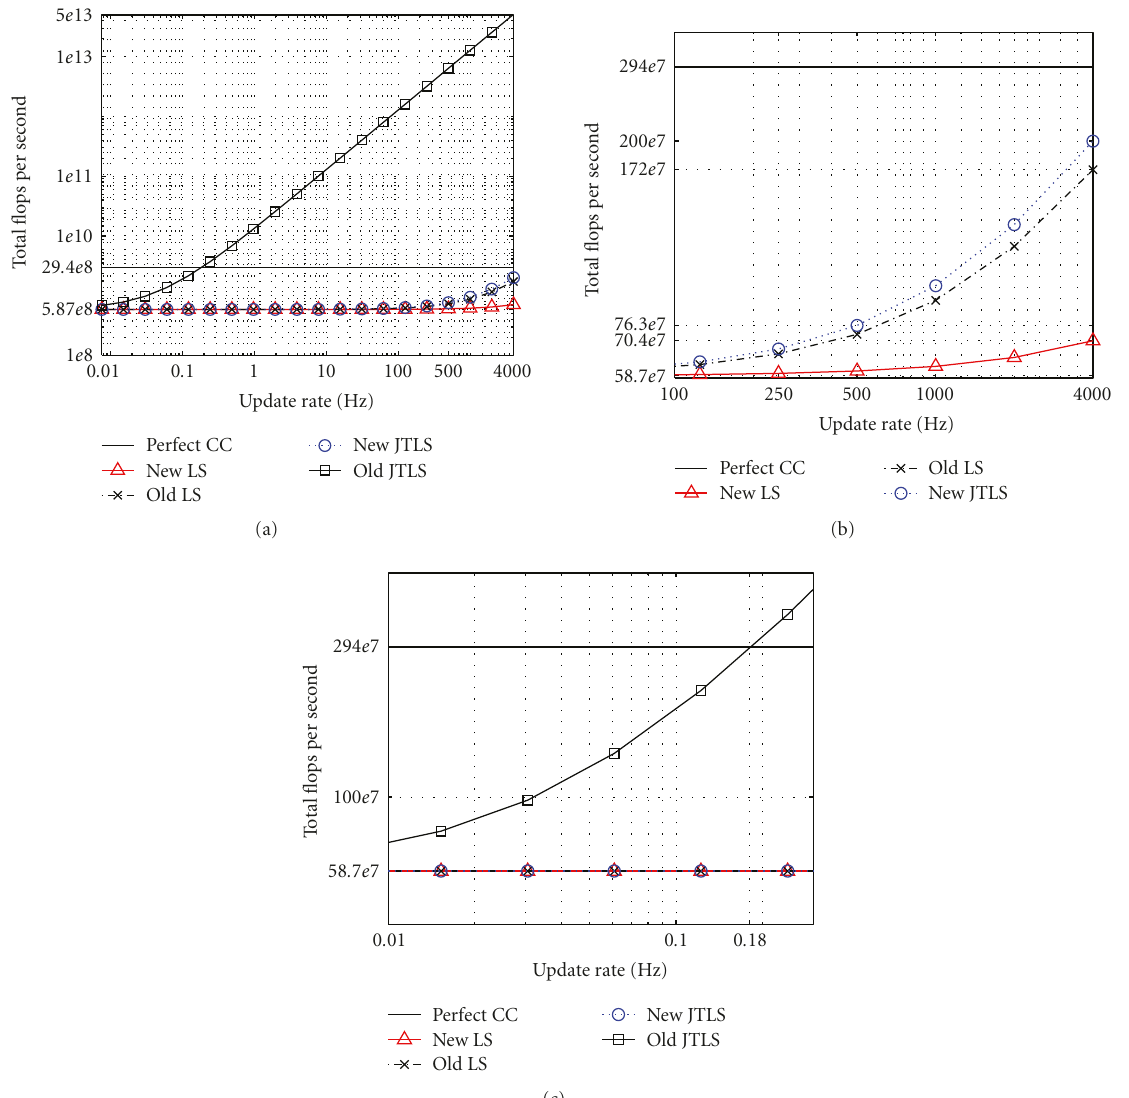
Figure 1: (a) The total number of flops (including online and recurrent complexities) per user for perfect crosstalk canceller (perfect CC), our new LS scheme (new LS), the LS scheme in [5, 6] (old LS), our new JTLS schemes (new JTLS) assuming K 1 = K 2 = 11, and the JTLS scheme in [5, 6] (old JTLS) for L = 25 and p = 5, (b) a closer look at the performance of our LS scheme, the LS scheme in [5, 6], and our new JTLS scheme and (c) a closer look at the performance of the JTLS scheme in [5, 6].